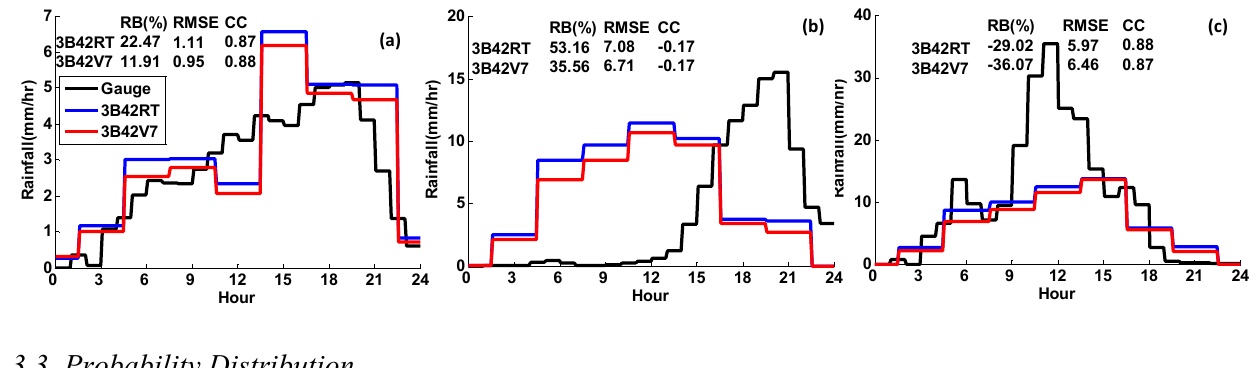
Figure 4. Time series rainfall over ( a ) entire HBT domain; ( b ) Beijing; and ( c ) rainfall